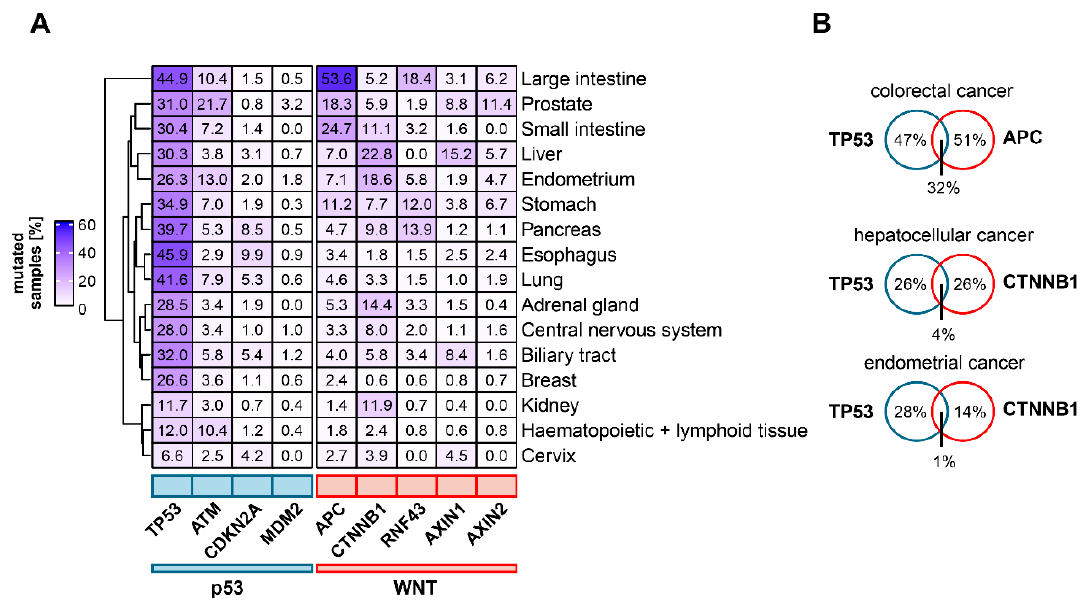
Figure 2. Mutational status of frequently mutated genes of the Wnt- and p53 pathways in different cancer entities. ( A ) Frequencies of mutations in Wnt and p53 pathway related genes in selected cancer entities. Percentage of samples with somatic mutations for the respective gene in the selected tissue type is shown. ( B ) Examples for mutual exclusive and co-occurring mutations in Wnt and p53 pathway associated genes. For Venn diagrams, only samples which were tested for mutations in both of the indicated genes were included. For this subset, the percentage of samples with mutations of either one or both genes were calculated. Tumor genome sequencing data were obtained from the COSMIC database [114].